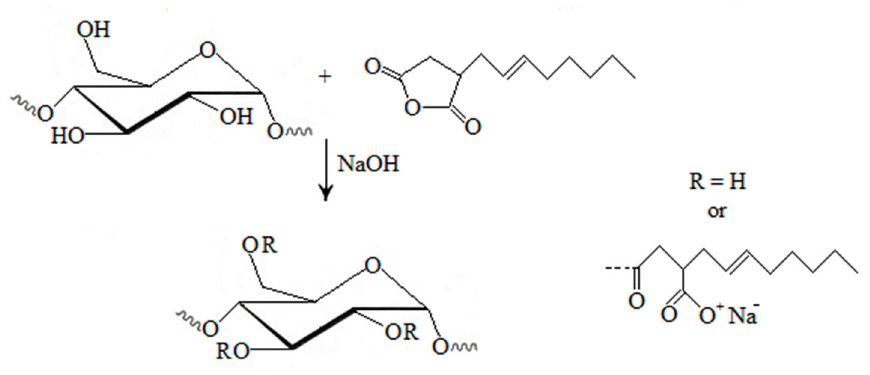
Figure 2. Starches modified with octenyl succinic anhydride